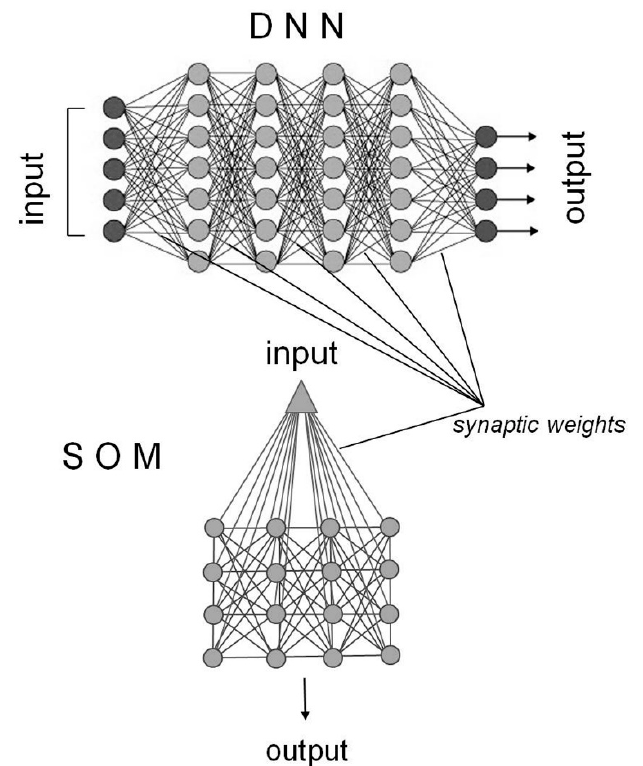
Figure 3. Functional architecture of a deep neural network (DNN) (top) with four fully connected hidden layers of neurons between input and output layers, and that of a self-organized map (SOM) with a single layer of fully connected neurons between input and output. The SOM reduces the input dimensionality in order to represent the input distribution as a map. For learning, it generally uses winner-take-all, while a DNN may use a multitude of learning algorithms, at multiple steps of processing.